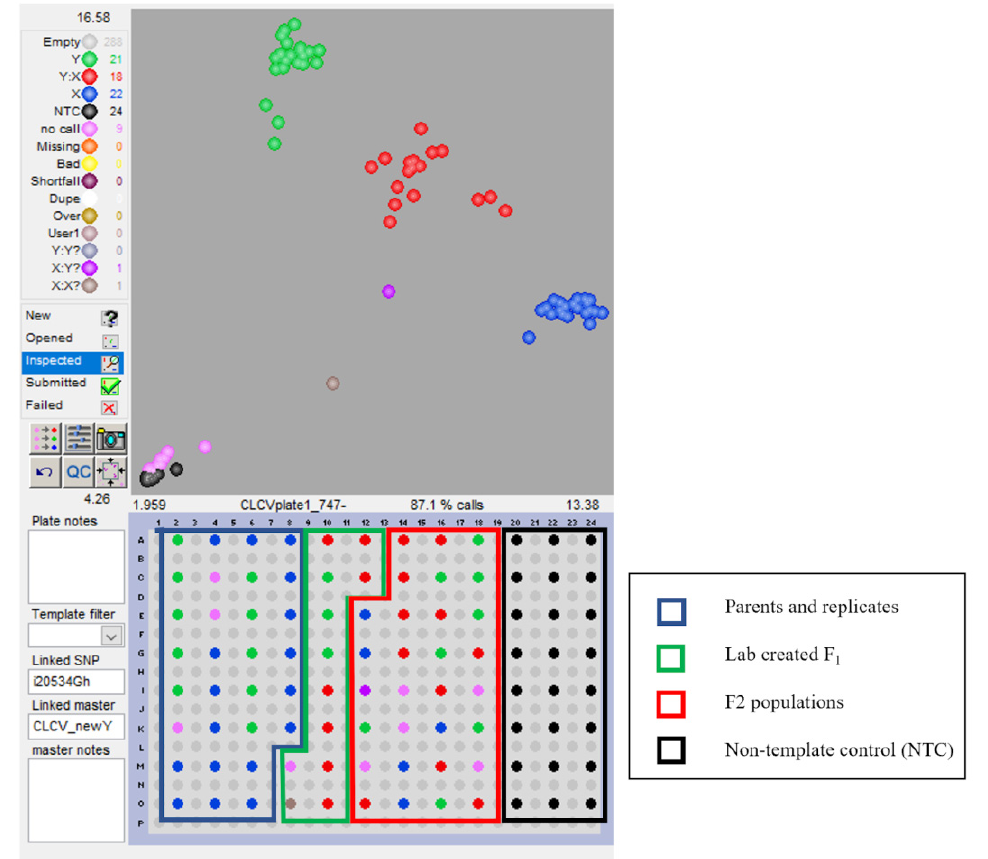
Figure 4. Overview of screening the KASP primer for marker i20534Gh. Image shown at PCR cycle 49 is an example of a selected “good” marker. The top half of the figure shows the clustering of homozygous individuals from the panel from the heterozygous individuals. The design of the testing panel is in the bottom half of the figure with boxes drawn to show sample